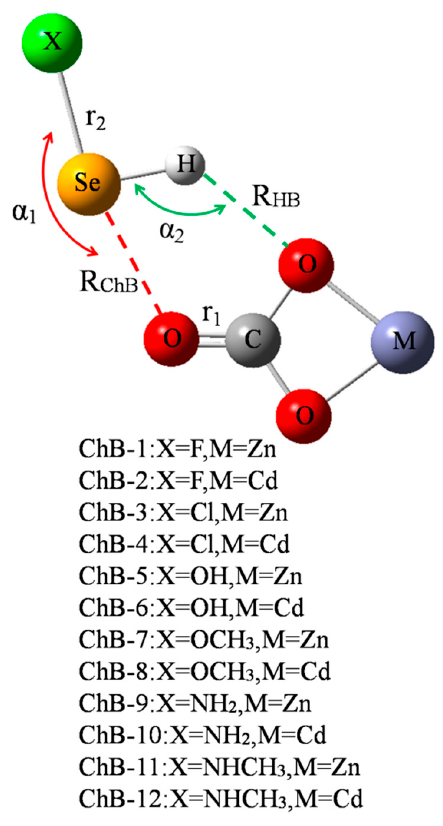
Figure 1. Scheme of chalcogen-bonded dyad. Table 1. Angles ( α , deg), binding distances (R, Å), change of bond length ( Δ r, Å), and interaction energy ( ∆ E, kcal/mol) in the chalcogen-bonded dyads.